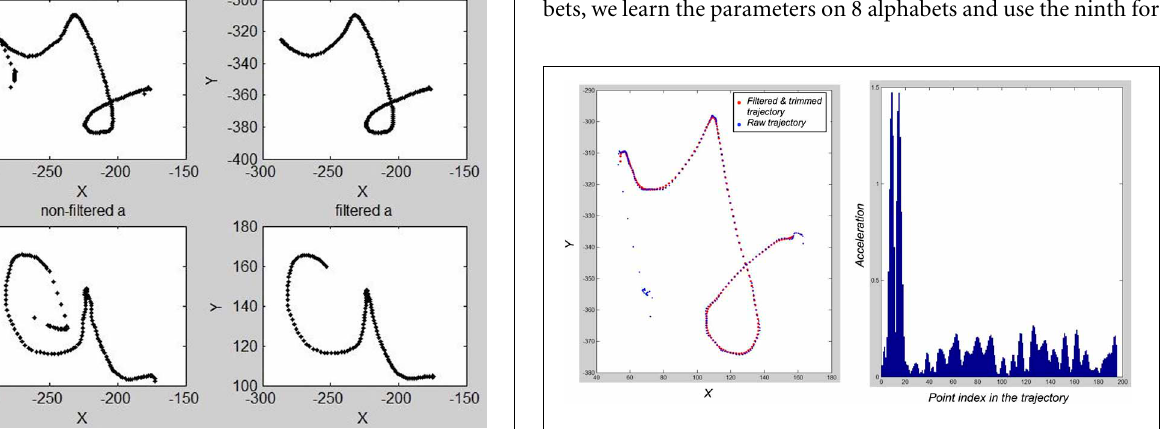
FIGURE 3 | Examples of “y” and “a” letters before (Left) and after (Right) the trimming process designed to remove intrusive saccades at the beginnings and ends of trajectories, and the filtering of high frequency components.